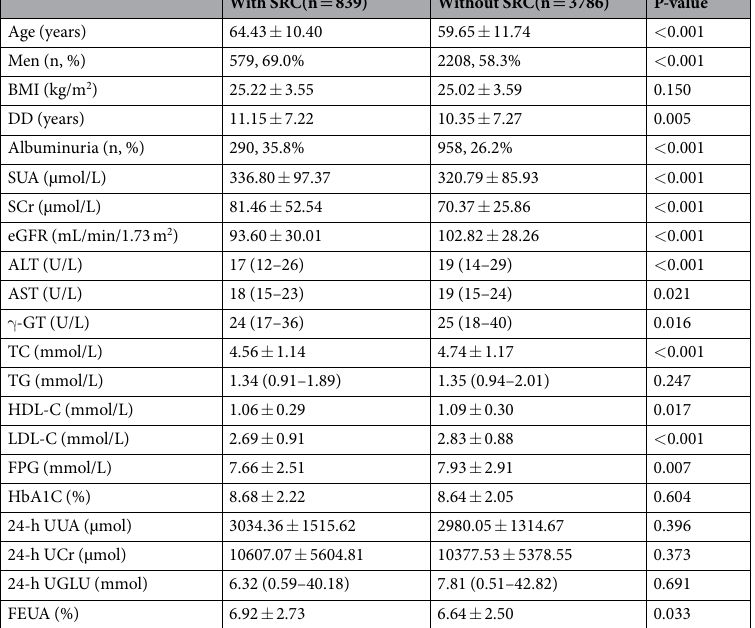
Table 1. Clinical characteristics of subjects with and without SRC. Continuous variables of normal distribution were expressed as mean ± SD and compared by the Student’s t test. Non-normal distribution variables were expressed as and median (interquartile range 25–75%) and compared by the Mann-Whitney U test. Categorical variables were expressed as percentages and compared by the Chi-square test. SRC, simple renal cysts; BMI, body mass index; DD, duration of diabetes; SUA, serum uric acid; SCr, serum creatinine; eGFR, estimated glomerular filtration rate; ALT, alanine aminotransferase; AST, aspartate aminotransferase; γ -GT, γ -glutamyl transferase; TC, total cholesterol; TG, total triglycerides; HDL-C, high-density lipoprotein cholesterol; LDL- C, low-density lipoprotein cholesterol; FPG, fasting plasma glucose; HbA1c, glycosylated hemoglobin;